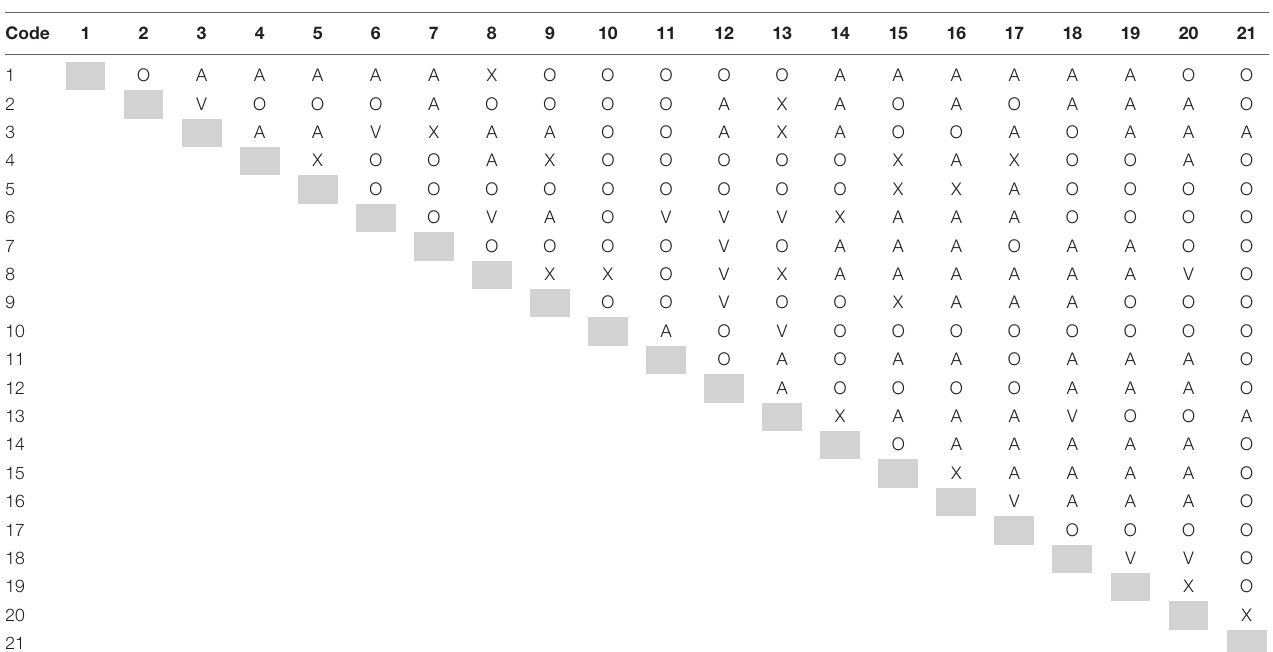
TABLE 2 | Structural Self-Interaction Matrix